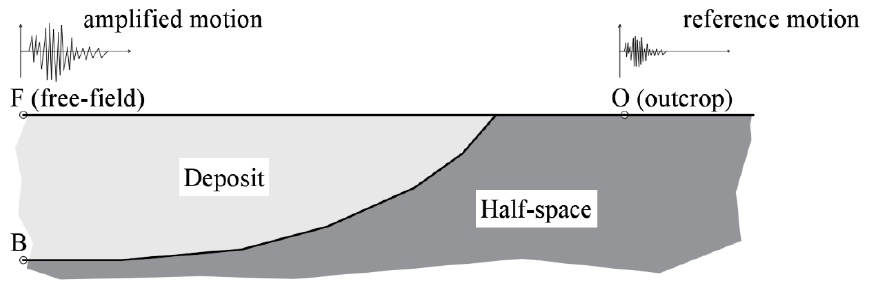
Figure 1. Simplified seismic site response scheme.